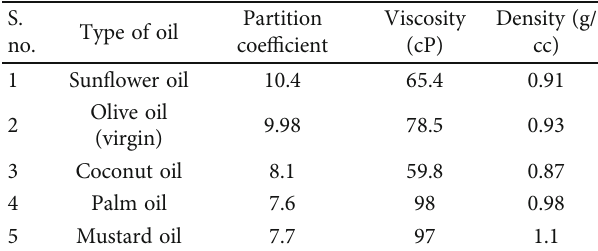
Table 1: Investigated vegetable oils along with their values for partition coe ffi cients, density, and